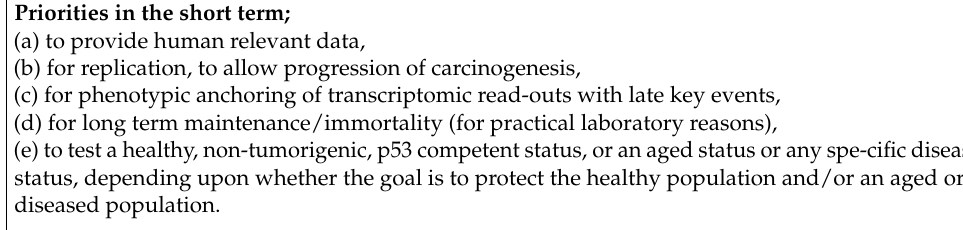
Box 1. Summary Box: Prioritised considerations for the selection of cells for transcriptomic read outs shall include the cell’s